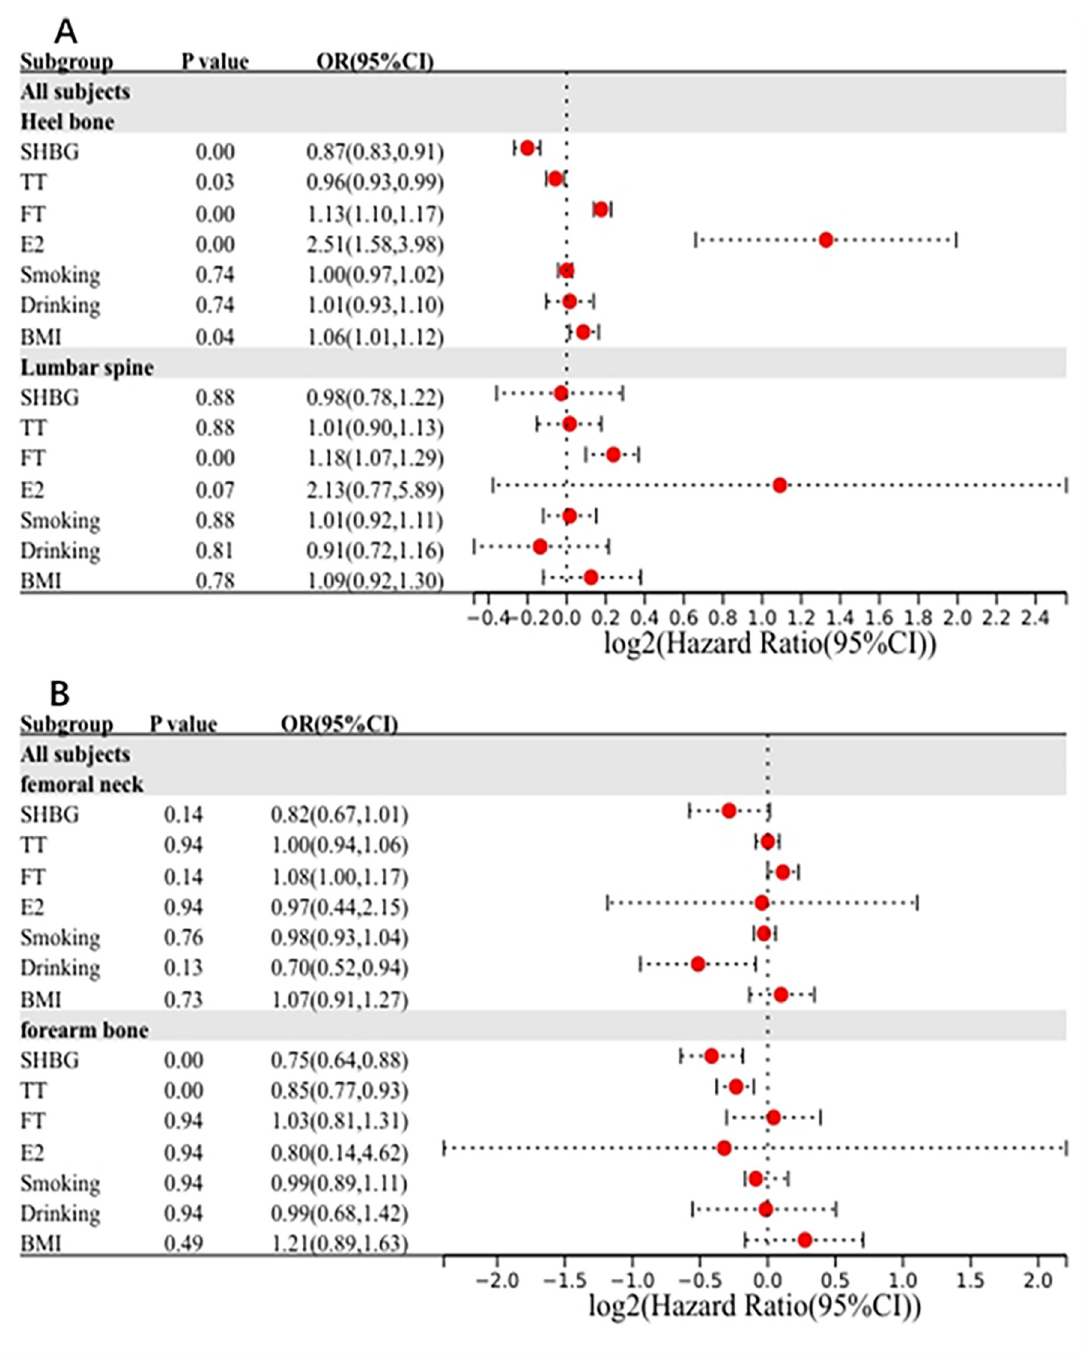
Fig 2. The forest plot of Mendelian randomization results. A is the results from bone mineral density of heel bone and lumbar spine; B is the results from bone mineral density of femoral neck and forearm bone.